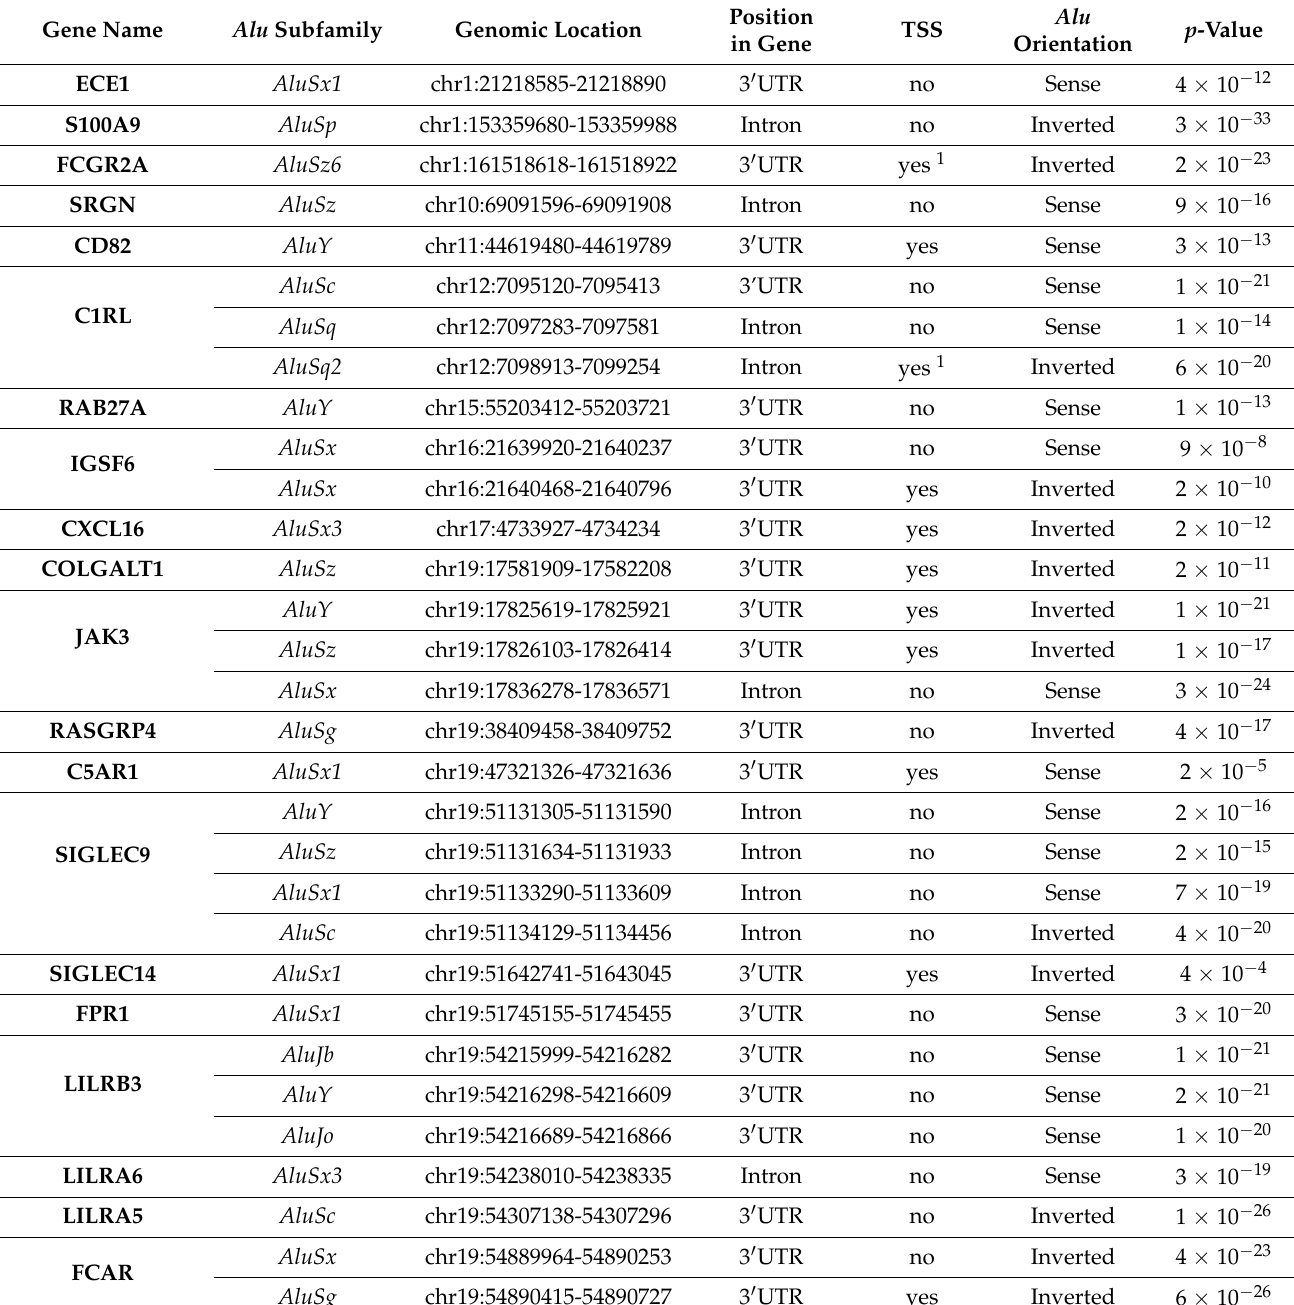
Table 1. List of 48 Alu elements embedded in immune